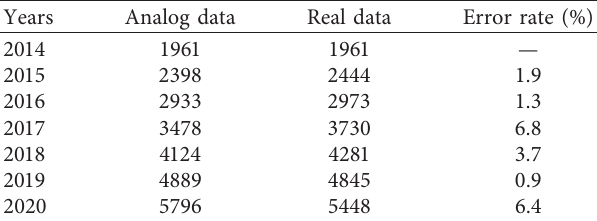
Table 4: Innovation performance fitting effect.